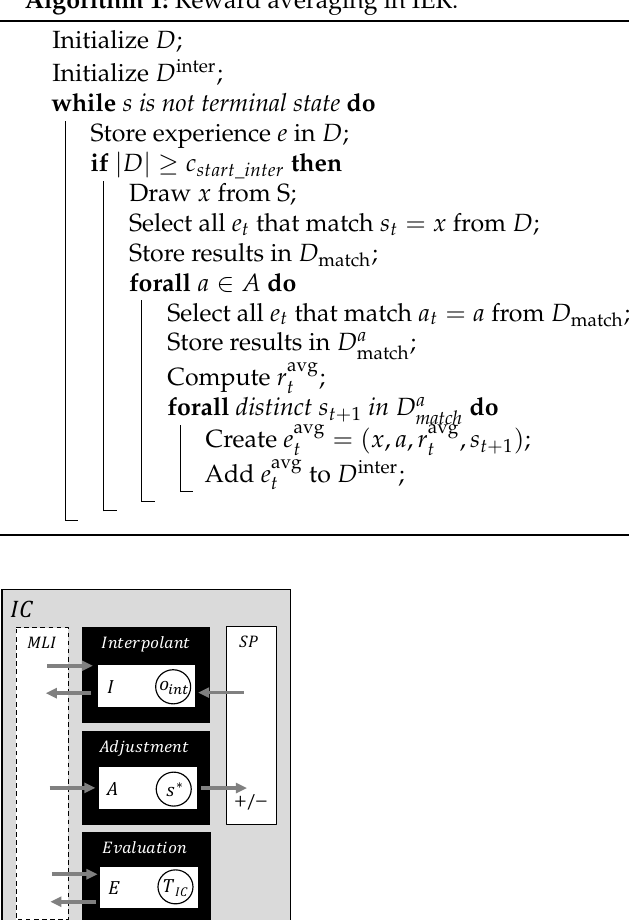
Algorithm 1: Reward averaging in IER.